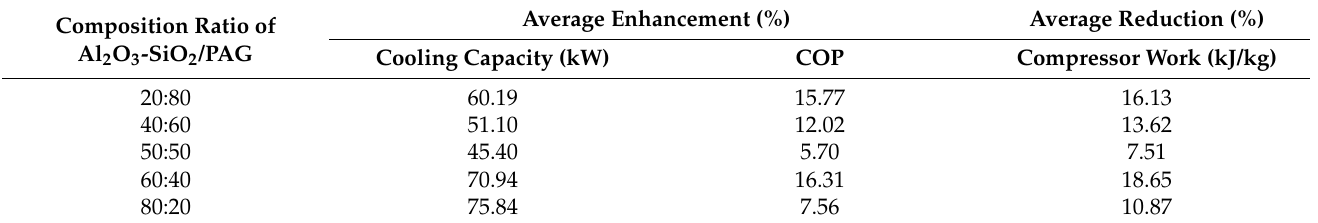
Table 5. Average enhancement for AAC system performance with variations in the Al 2 O 3 -SiO 2 composition ratios.